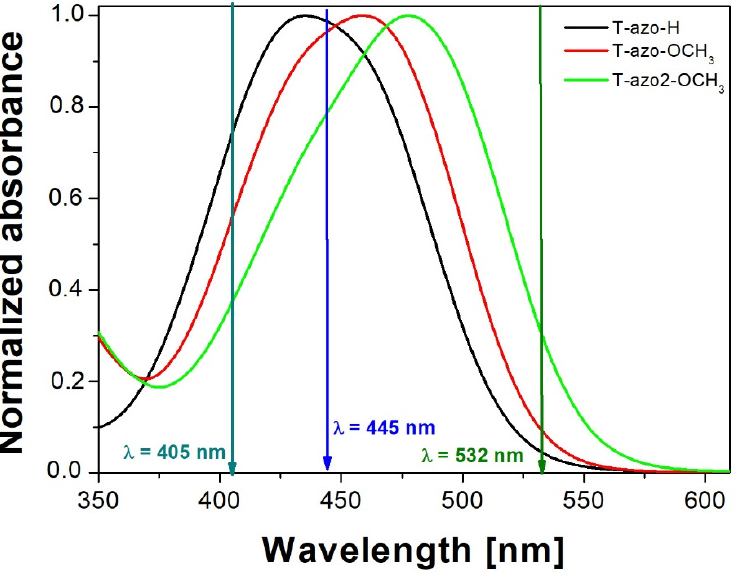
Figure 1. Normalized UV-Vis spectra of thiazole–azo dyes (molar concentration of dyes 27.2 mM) dispersed in PMMA matrix thin films: T–azo2–OCH 3 , T–azo–OCH 3 , T–azo–H with thickness 877 nm, 1128 nm, 1312 nm, respectively. The arrows indicate the absorbance of studied samples at the excitation wavelengths used.